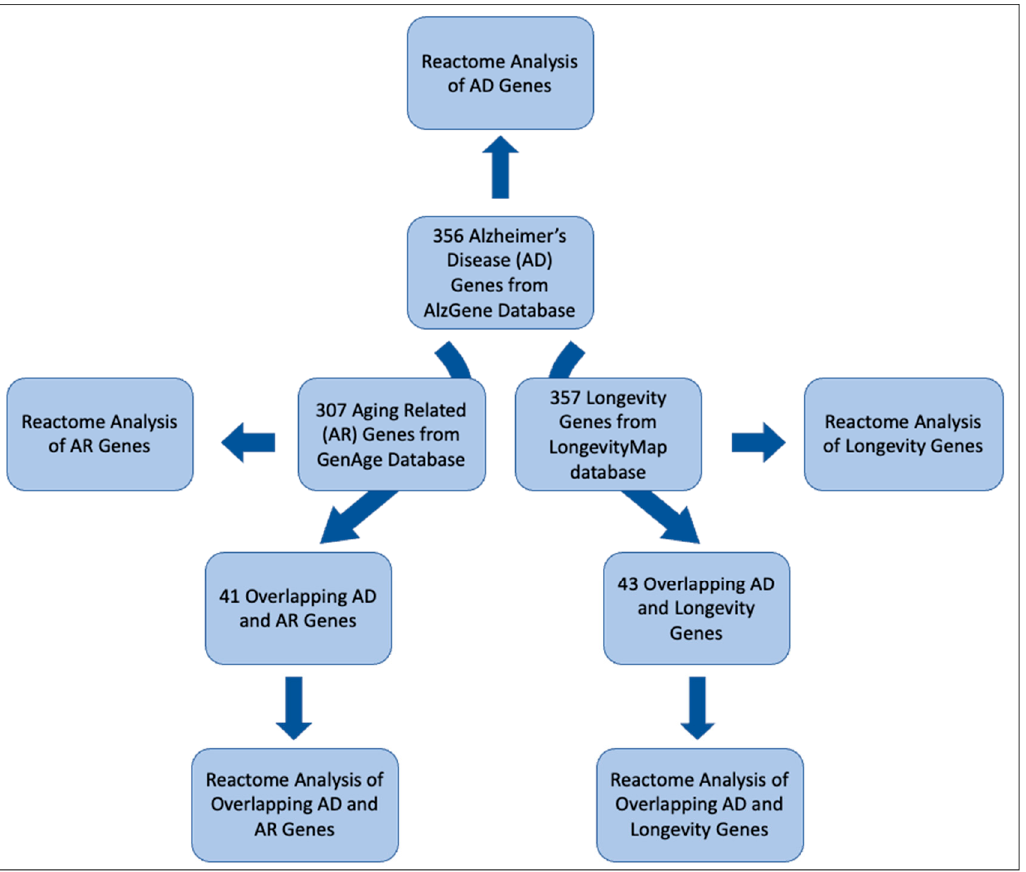
Figure 1. Schematic providing a breakdown of the methodology used in this study. We used the Reactome analysis for AD genes, AR genes, Longevity genes, overlapping AD and AR genes, and overlapping AD and Longevity genes.